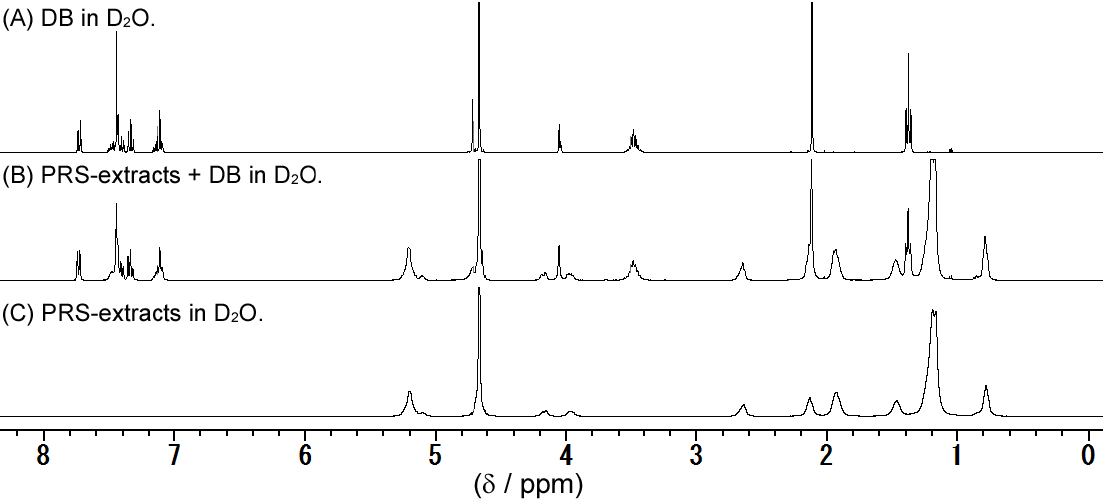
Figure 3. The 1 H NMR spectra (400 MHz, 298 K, D 2 O). ( A ) DB in D 2 O solution; ( B ) PRS extracts + DB in D 2 O solution; and ( C ) PRS extracts in D 2 O